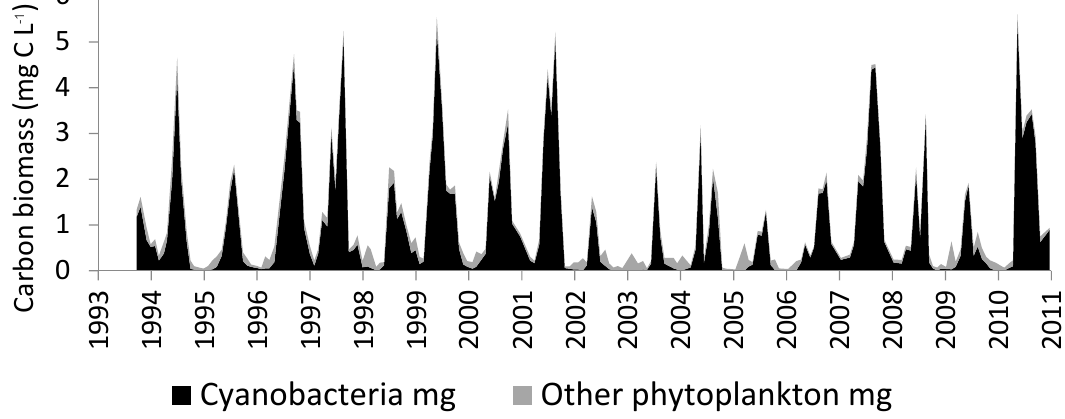
Figure 6. Time series of cyanobacteria ( black ) and all other ( grey ) phytoplankton carbon biomass in Lake George.